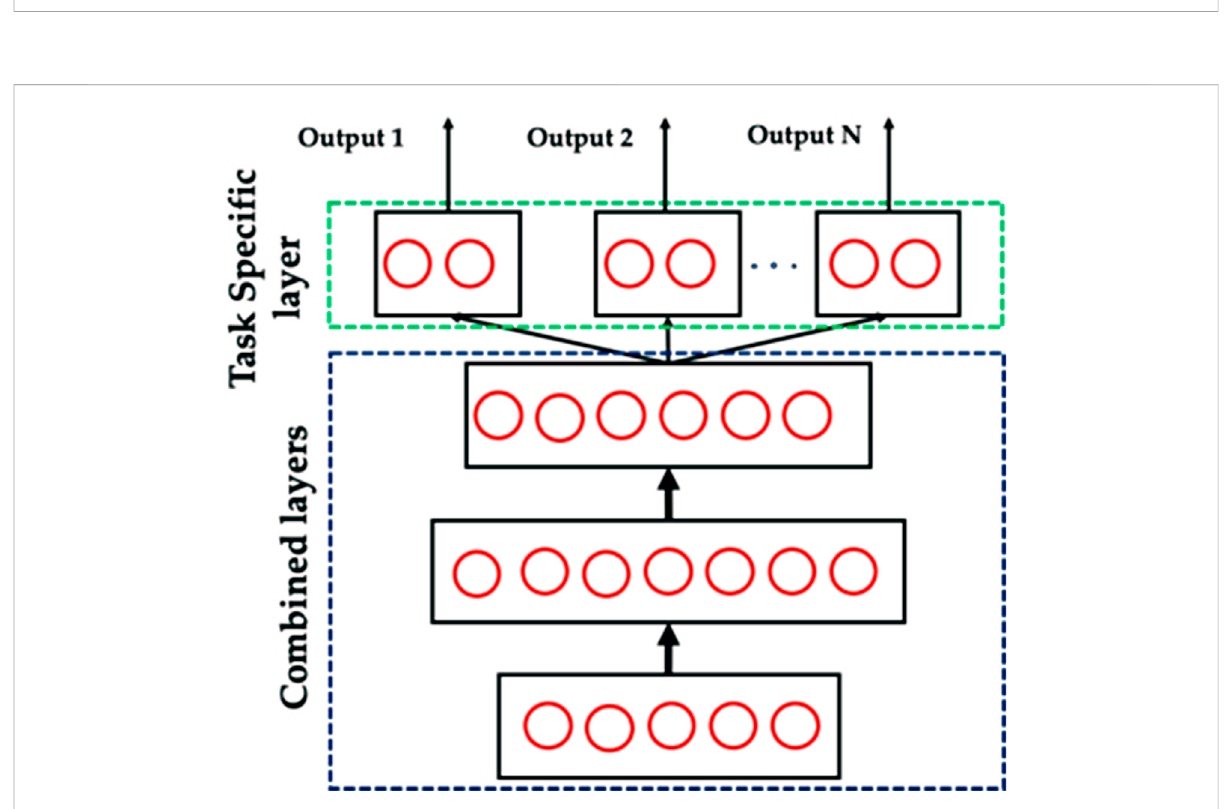
FIGURE 2 A typical representation of a neural network with multitasking